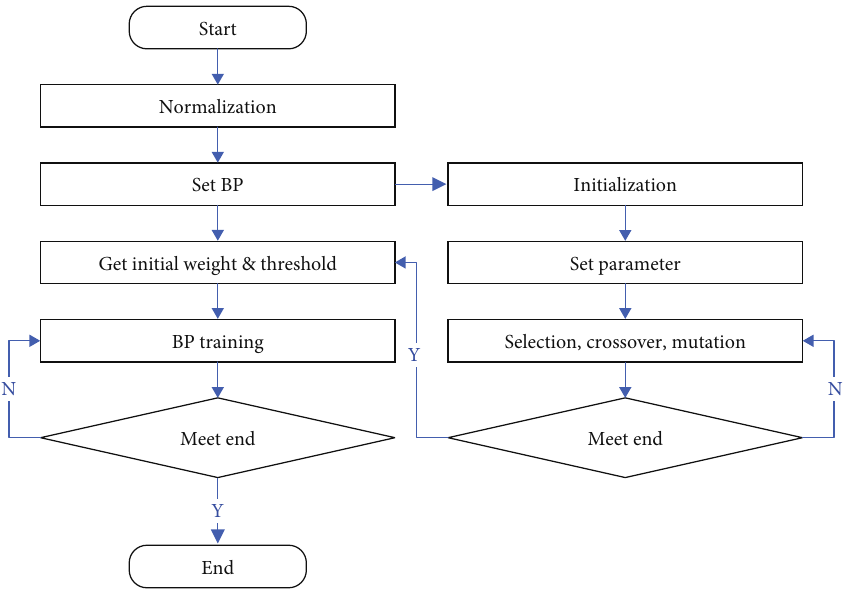
Figure 2: IGA-BP pipeline. Table 1: Teaching quality evaluation